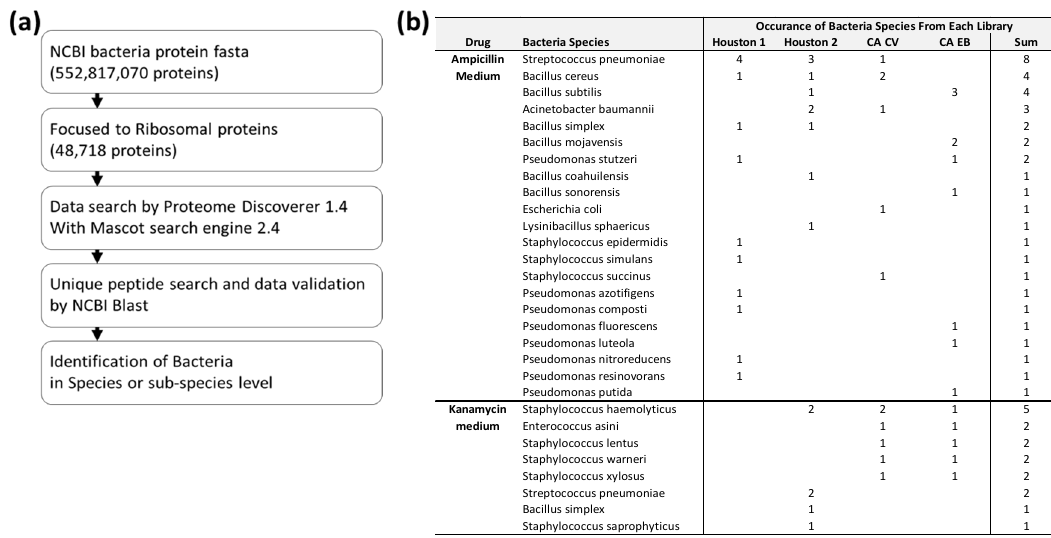
Figure 3. ( a ) Schematic illustration of workflow for identification of bacteria in species or subspecies level using unique peptide identification method. ( b ) Summary of confirmed bacteria species.